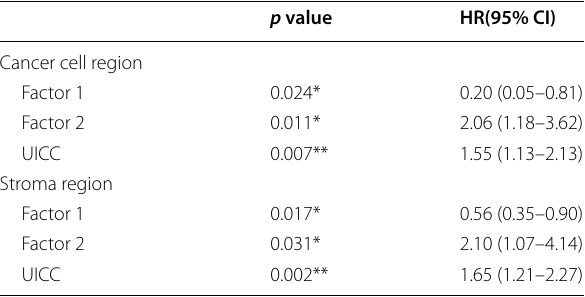
Table 4 Multivariate cox proportional hazard